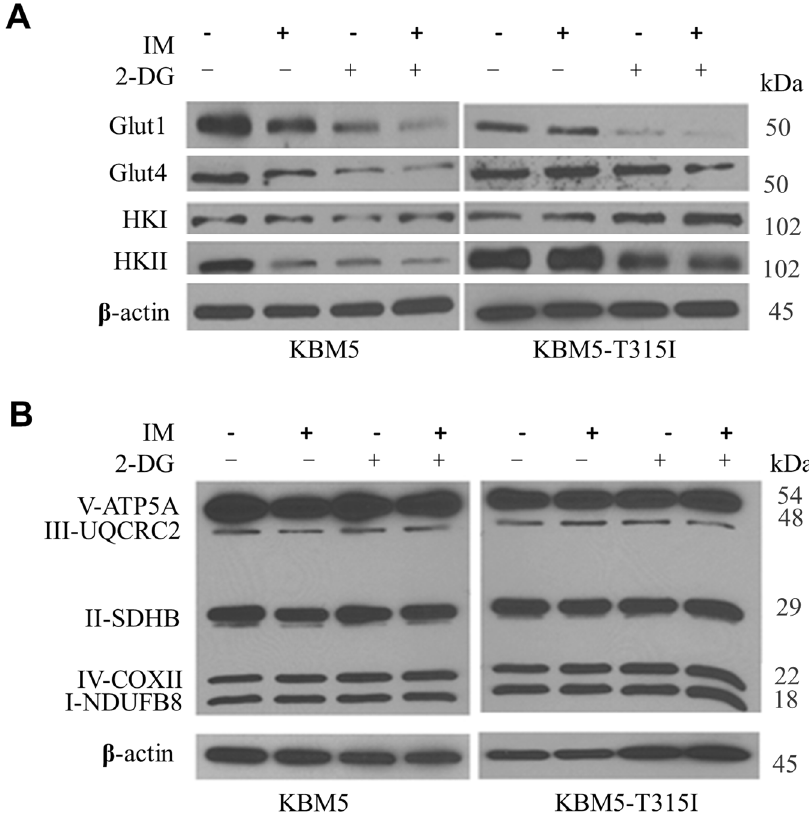
Fig. 5 Effect of 2-DG and imatinib on the expression of glucose transporters, hexokinases and mitochondrial ETC components. A KBM5 and KBM5-T315I cells were treated with 2-DG (2 mM) and/or IM (0.1 μ M for KBM5 cells and 5 μ M for KBM5-T315I cells) for 48 h, and proteins were isolated for western blot analysis of Glut-1, Glut4, HKI, HKII and β -actin. B KBM5 and KBM5-T315I cells were treated with 2-DG (2 mM) and/or IM (0.1 μ M for KBM5 cells and 5 μ M for KBM5-T315I cells) for 48 h, and proteins were isolated for western blot analysis of fi ve key complexes of OXPHOS and β